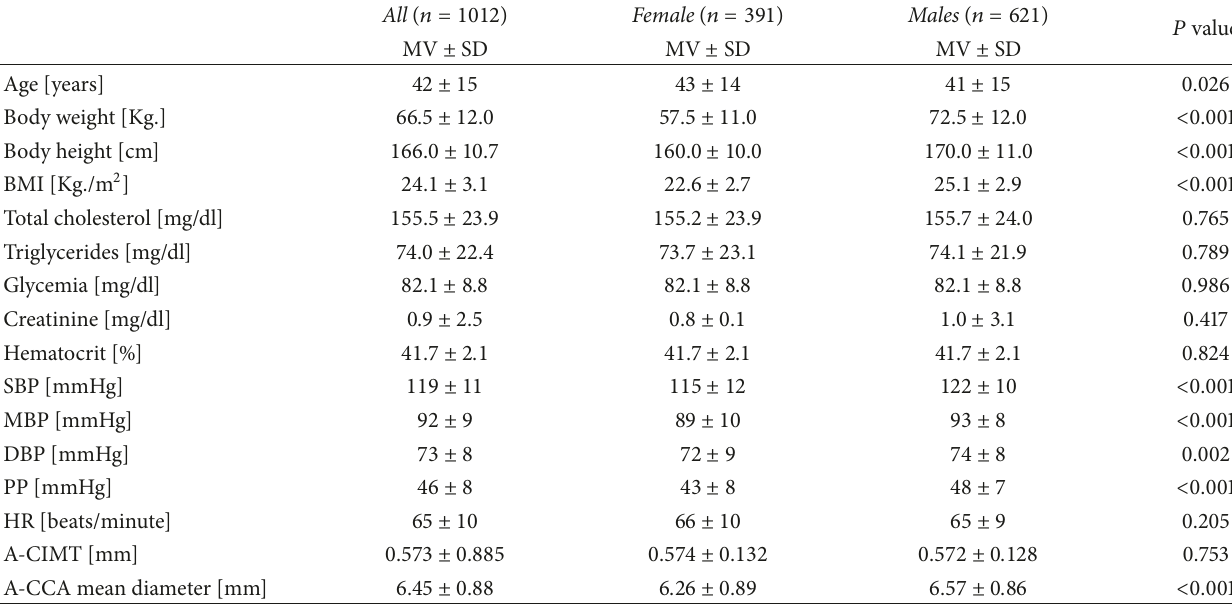
Table 1: Subjects